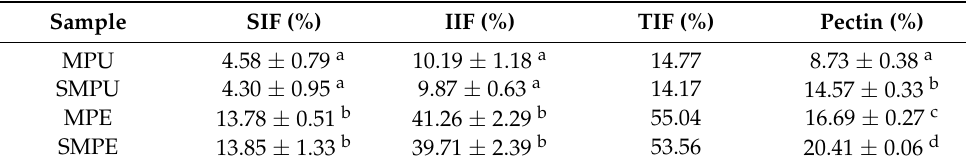
Table 1. Indigestible fraction characterization of umbu